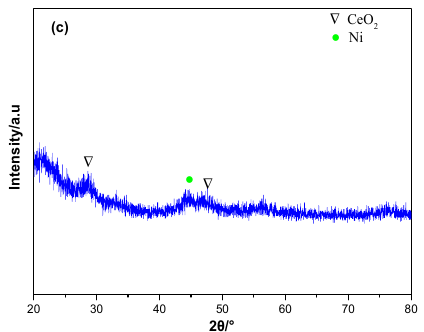
Figure 8. ( a,b ) Transmission electron microscopy images and ( c ) X-ray diffraction pattern of the used 50% Ni-CeO 2 -CSC catalyst.